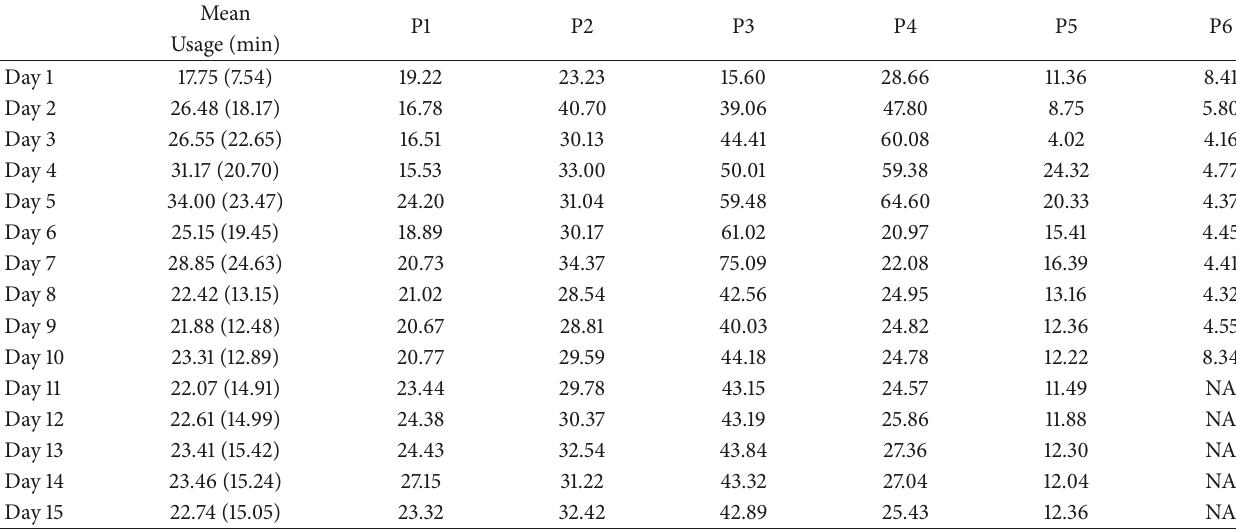
Table 3: Total device usage in minutes for all waveforms training